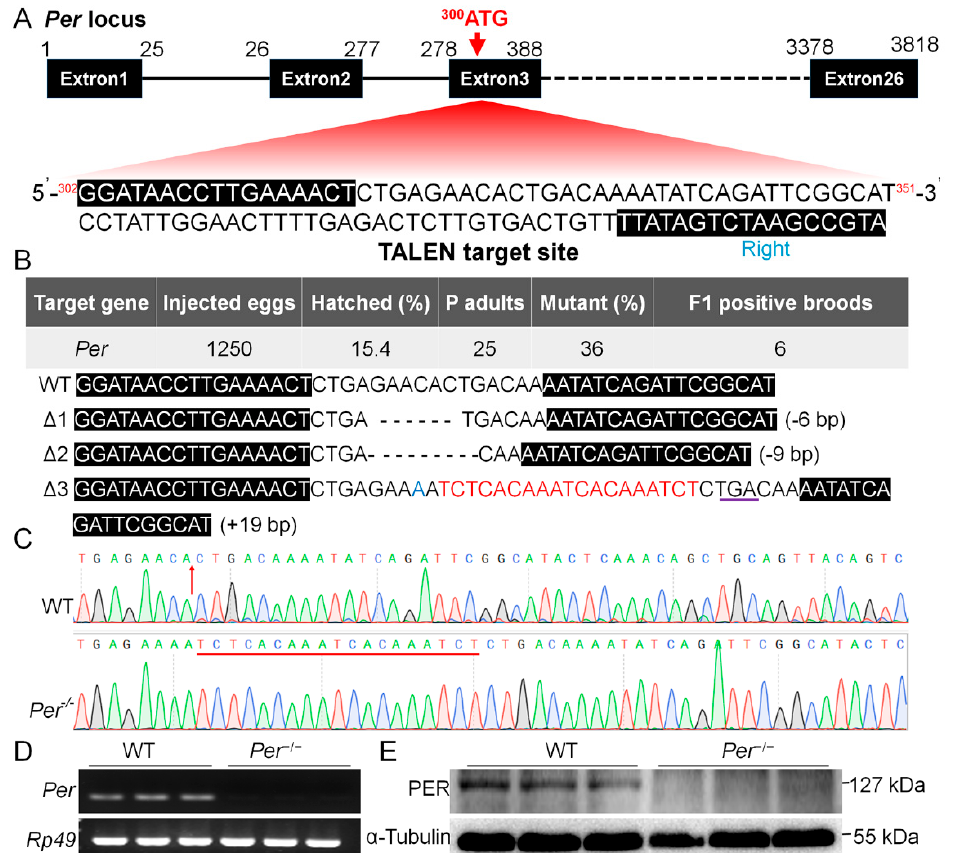
Figure 1. The target site for knockout Period gene ( Per ) and the mutant screening in B. mori. ( A ) Gene structure and the TALEN knockout sequences (302G...351T) designed for the transcription start site (300ATG) located on the third exon of Per . ( B ) Mutant screening efficiency and the 3 types of Per gene mutations screened. ( C ) Sequencing peak map of ∆ Per-3 mutant. ( D , E ) Verification of Per knockout effect on mRNA level and protein level respectively. The material is the newly hatched larvae ( n = 3 batches, 200–300 larvae per batch).